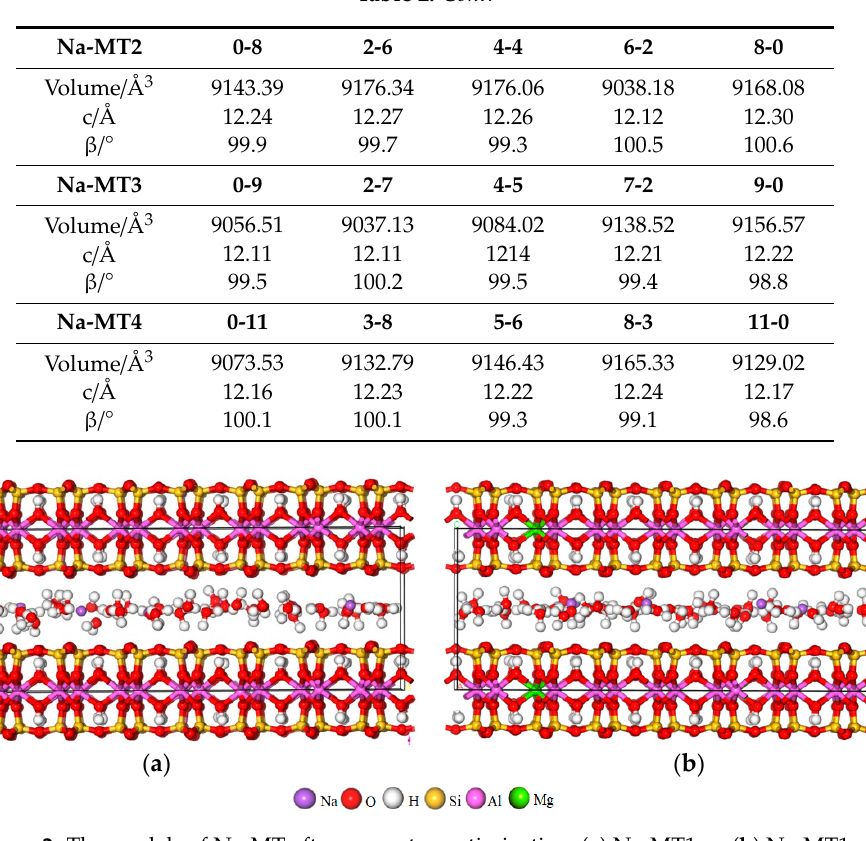
Figure 2. The models of Na-MT after geometry optimization, ( a ) Na-MT1 0-6 ; ( b ) Na-MT1 6-0 .